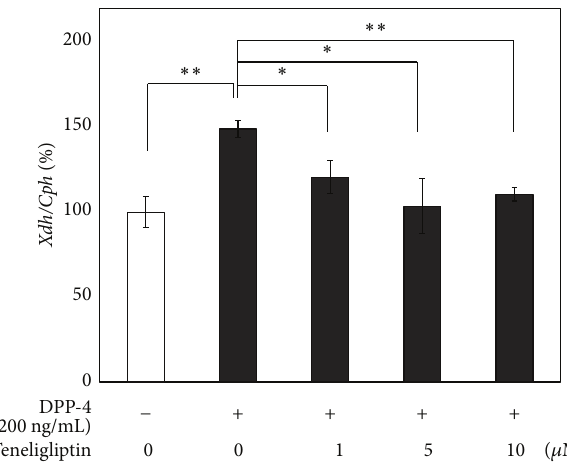
Figure 6: Effects of DPP-4 and teneligliptin on Xdh expression in 3T3-L1 adipocytes. Serum-starved 3T3-L1 adipocytes were treated without ( ◻ ) or with DPP-4 ( ◼ ; 200 ng/mL) and teneligliptin (1, 5, and 10 𝜇 M) for 12 hours. Total RNAs extracted from all cells were used for gene expression analysis of Xdh. Levels of Cph were used for normalization of sample loading. Data are the means ± SEM of 3 independent experiments (1 experiment performed with 6 samples). Data are expressed relative to control values. ∗ 𝑃 < 0.05 ; ∗∗ 𝑃 < 0.01 versus DPP-4 treated control cells.